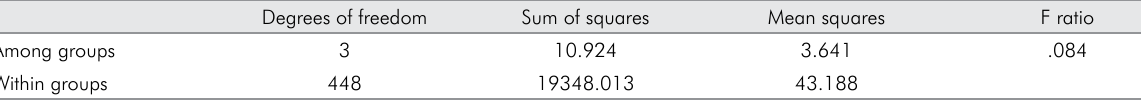
Table 3. ANOVA-based study results.